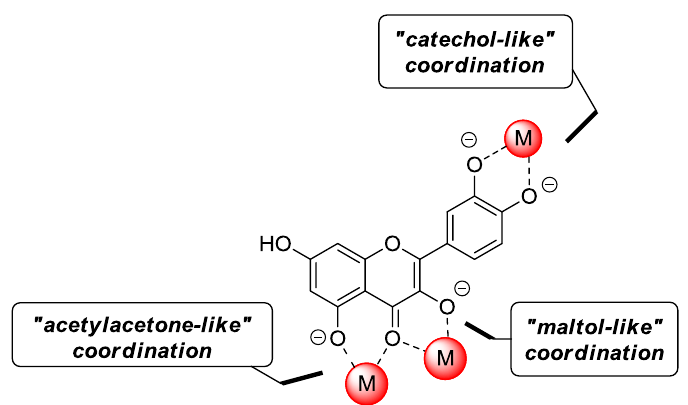
Figure 10. Possible coordination modes of quercetin with metal ions (M).